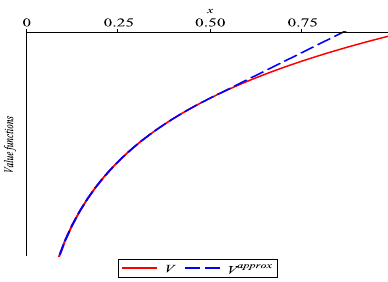
Figure 7. Intentional underestimation of the value function on some interval not influencing the optimal state and consumption trajectories in Example 1.